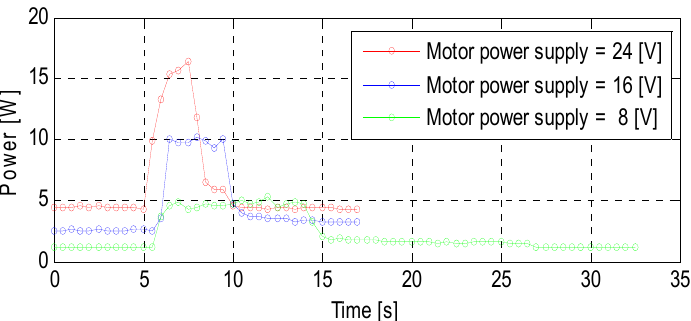
Figure 2. Power consumption during drillability test performed for grey foamglas F sample using Makita coring bit for three different motor’s power supply voltage: 24, 16, and 8 V. WOB = 27.27 N.